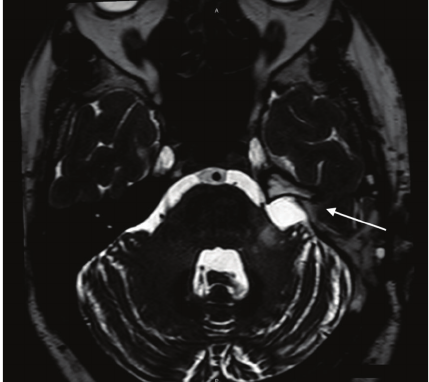
Figure 5: Axial MR image (T2 weighted, 3D DRIVE CLEAR) showing the postoperative changes.